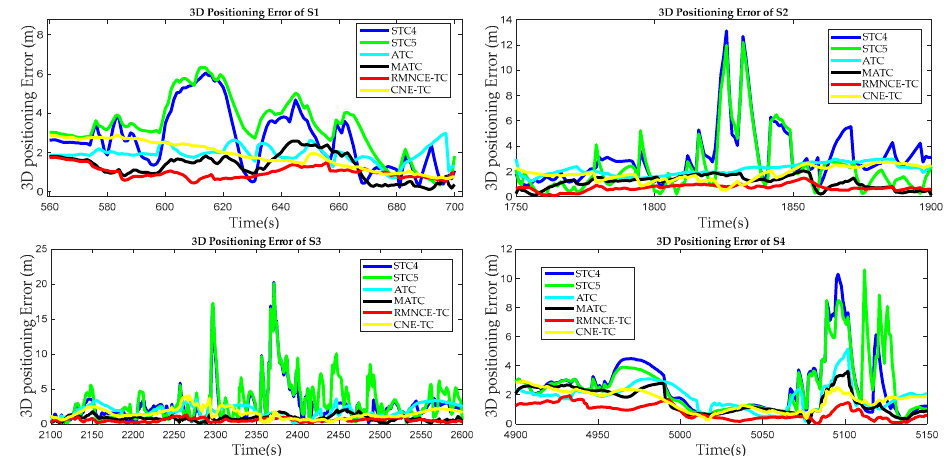
Figure 20. 3D positioning errors of the different test schemes during segments S1, S2, S3, and S4.